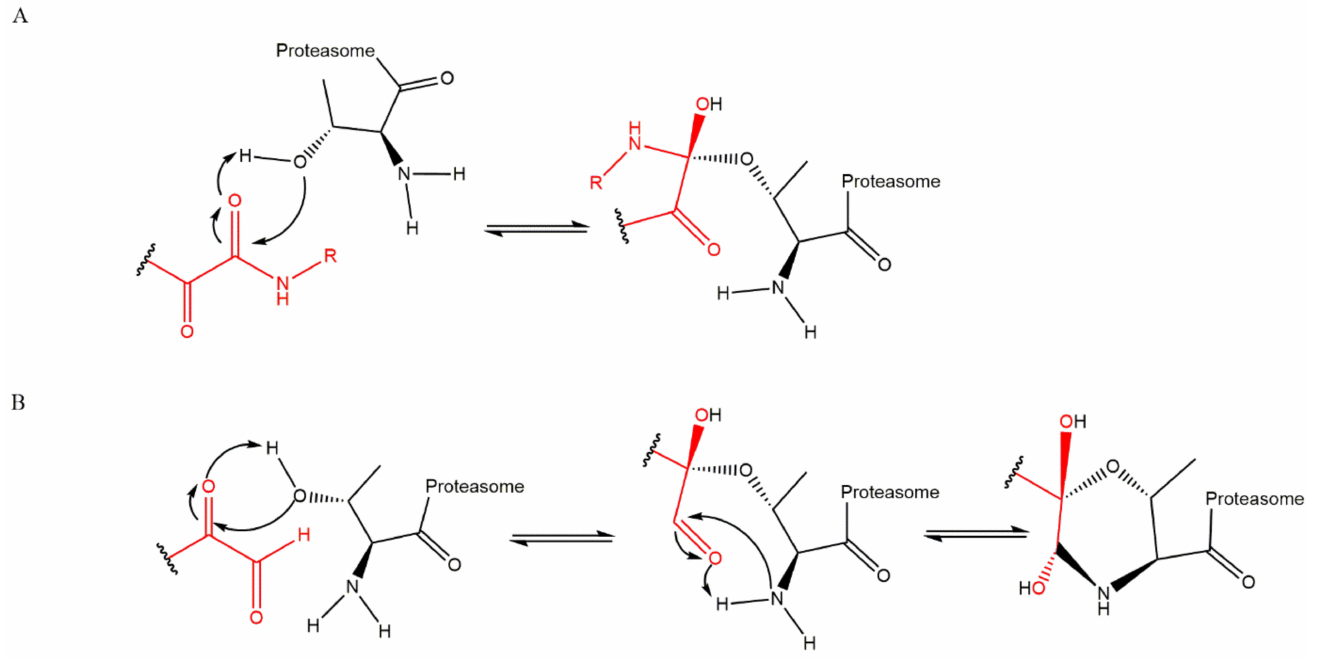
Figure 13. ( A ) Mechanism of proteasome inhibition by α -ketoamide inhibitor, where the hy- droxyl from Thr1 reacts with ketoamide group from inhibitor, with the formation of a hemiketal. ( B ) Mechanism of proteasome inhibition by α -ketoaldehyde inhibitor, where the hydroxyl and amine groups from Thr1 react, respectively, with ketone and aldehyde groups from inhibitor, promoting the formation of a 6-membered ring [29,30,55].